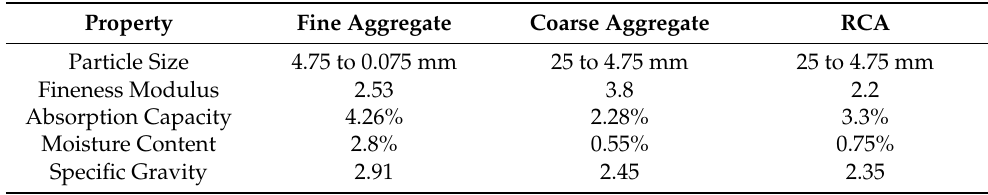
Table 3. Fine and coarse aggregate